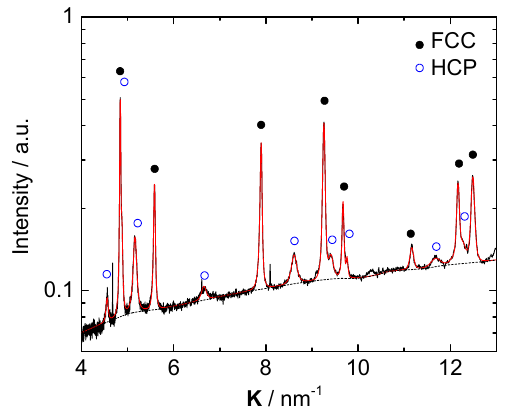
Quantum Beam Sci. 2018 , 2 , x FOR PEER REVIEW Figure 8. CMWP fitting to the neutron diffraction pattern of the CCM alloy rolled at 20%. (K = 1/ d = 2sin θ / λ ).